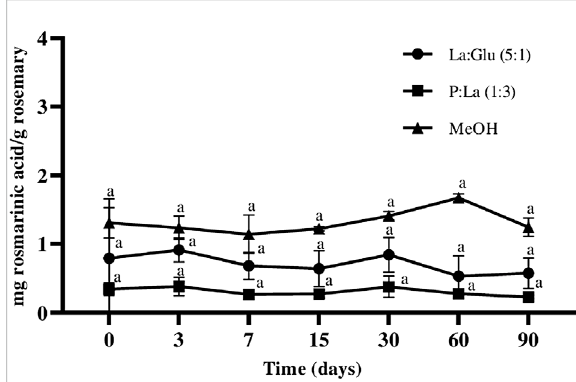
FIGURE 3 In fl uence of time on the content of rosmarinic acid extracted and kept in NADESs and Me0H. Values arc the average of three independent extracts replicates ±SD based on triplicate values. Statistically signi fi cant differences between the time points in each system are represented by letters. Different letters indicate signi fi cant differences within each